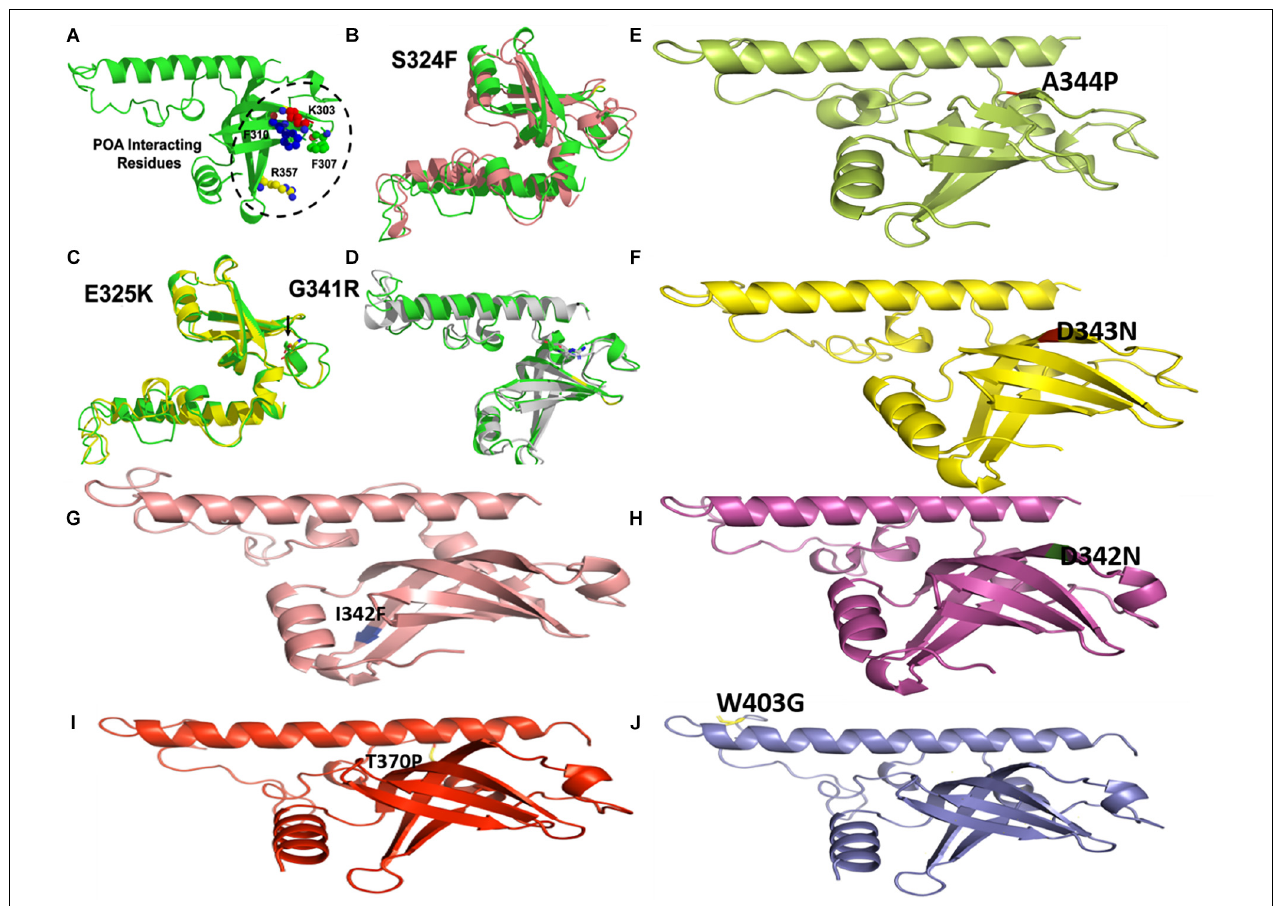
FIGURE 7 | Wild type and mutants RpsA structures. MTs have been highlighted at their original positions. (A) POA interacting residues have been shown. (E,I,J) Mutations in loop region. (B–D) Superimposed MTs and WT. (F–H) Mutations in helix